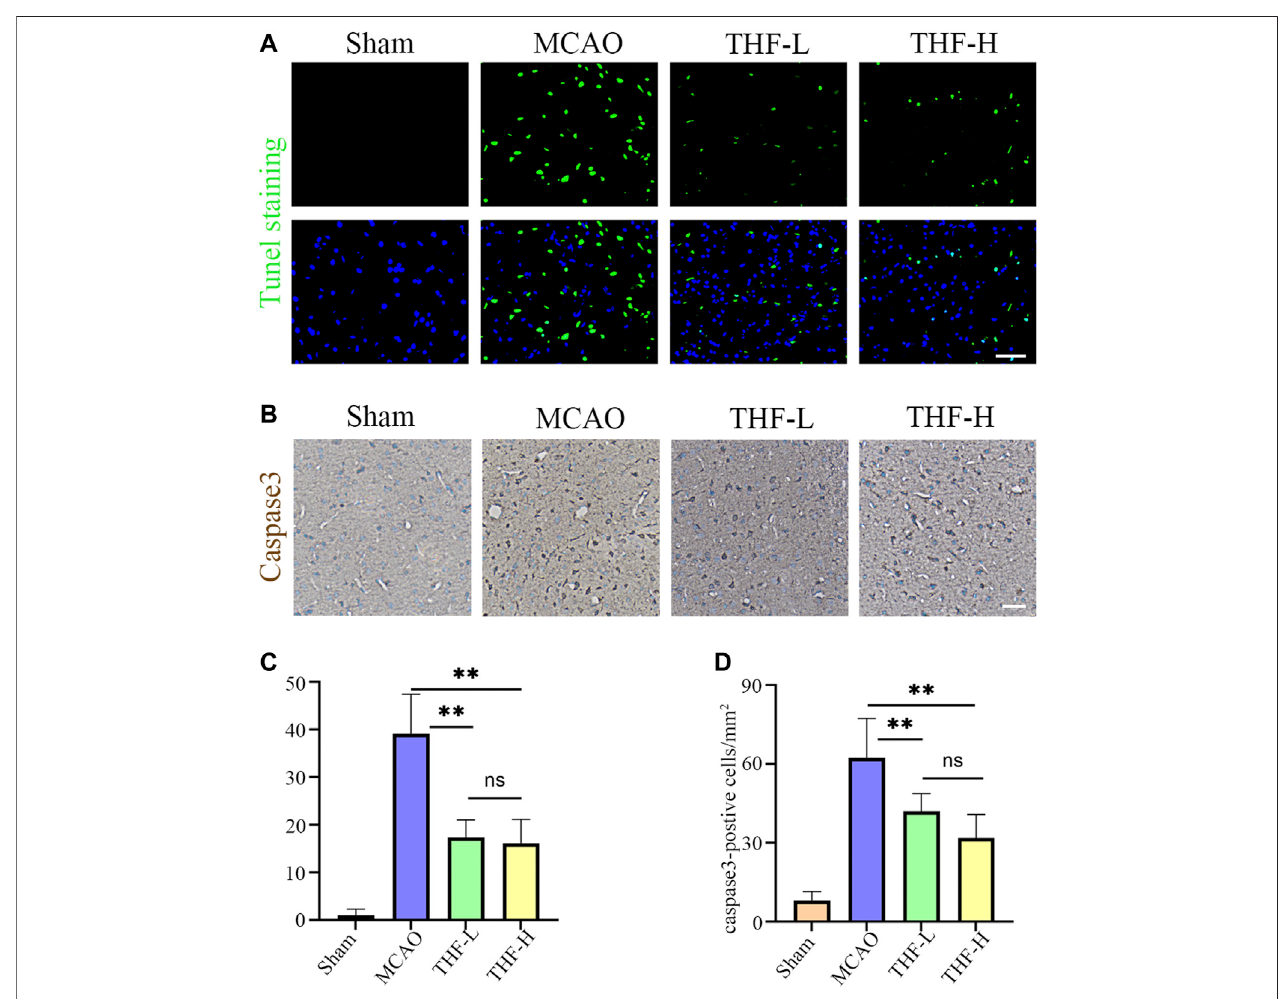
FIGURE 6 | Effects of THF on the neural cell apoptosis in infarction focus at 3 days and 30 min. (A) TUNEL staining of apoptotic cells in the cortex. Scale bar = 50 μ m. (B) Representative immunohistochemistry images showing caspase-3 – positive cells in the cortex. Scale bar = 100 μ m. (C) Quantitative analysis of apoptotic cells in the cortex. (D) Quanti fi cation of the number of caspase-3 – positive cells in each group. n = 3. (** p < 0.01, compared to the MCAO group).